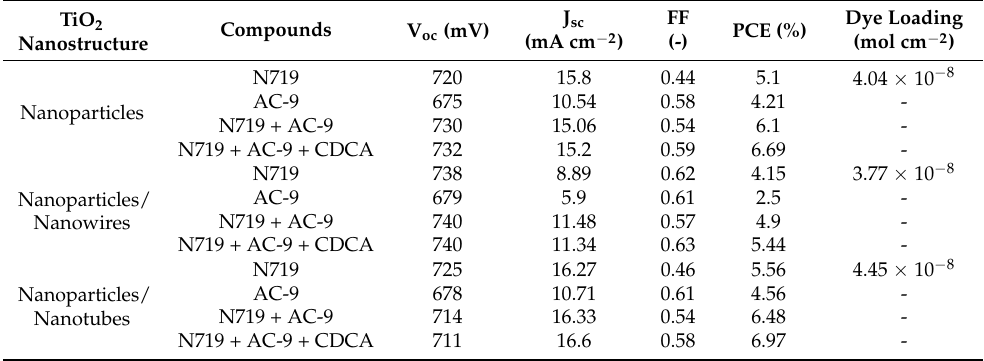
Table 2. Photovoltaic parameters of fabricated solar